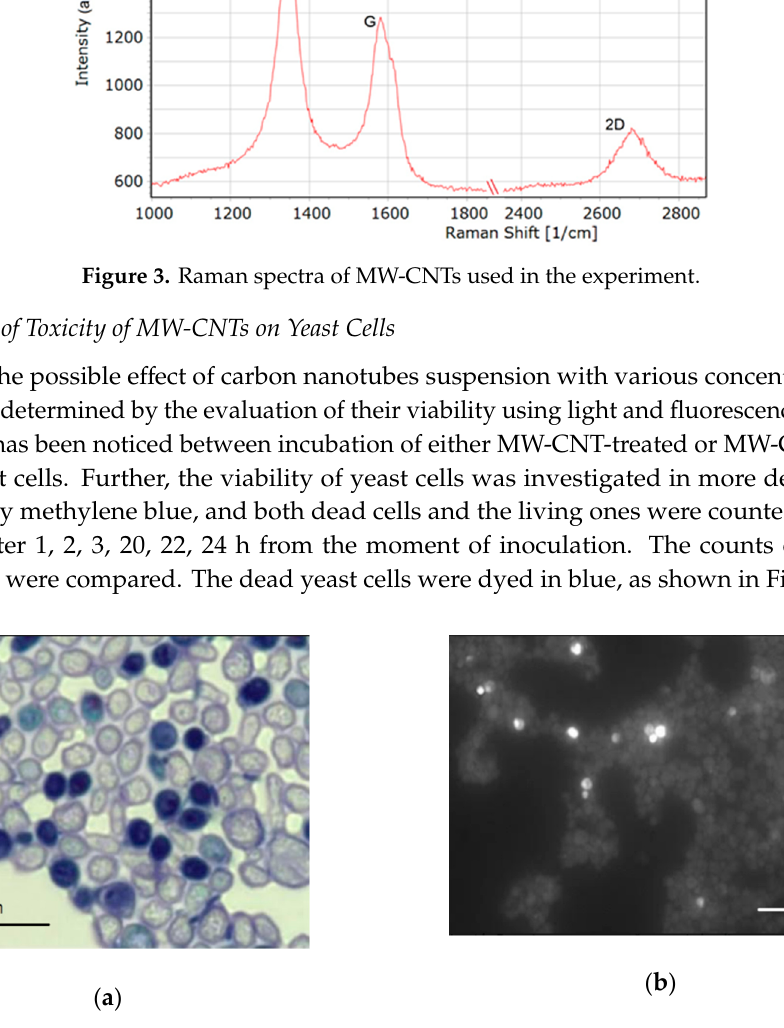
Figure 4. The images of the yeast Saccharomyces cerevisiae cells in an identical with field stained by: ( a ) methylene blue (bright cells, living; dark, dead) and ( b ) PI (bright, dead; dark, living).